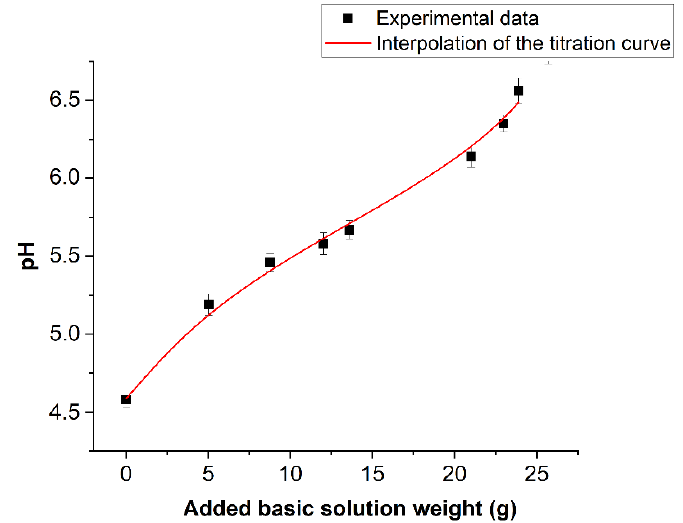
Figure 10. Trend of the average pH value measured after each complete deacidification treatment.